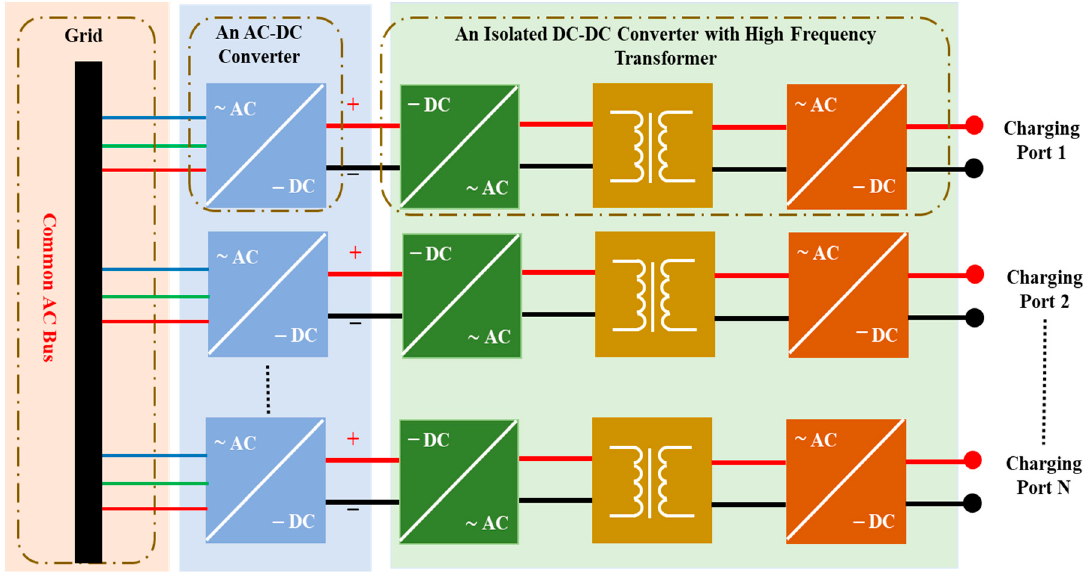
Figure 14 . Charging station with common AC bus. Figure 14. Charging station with common AC